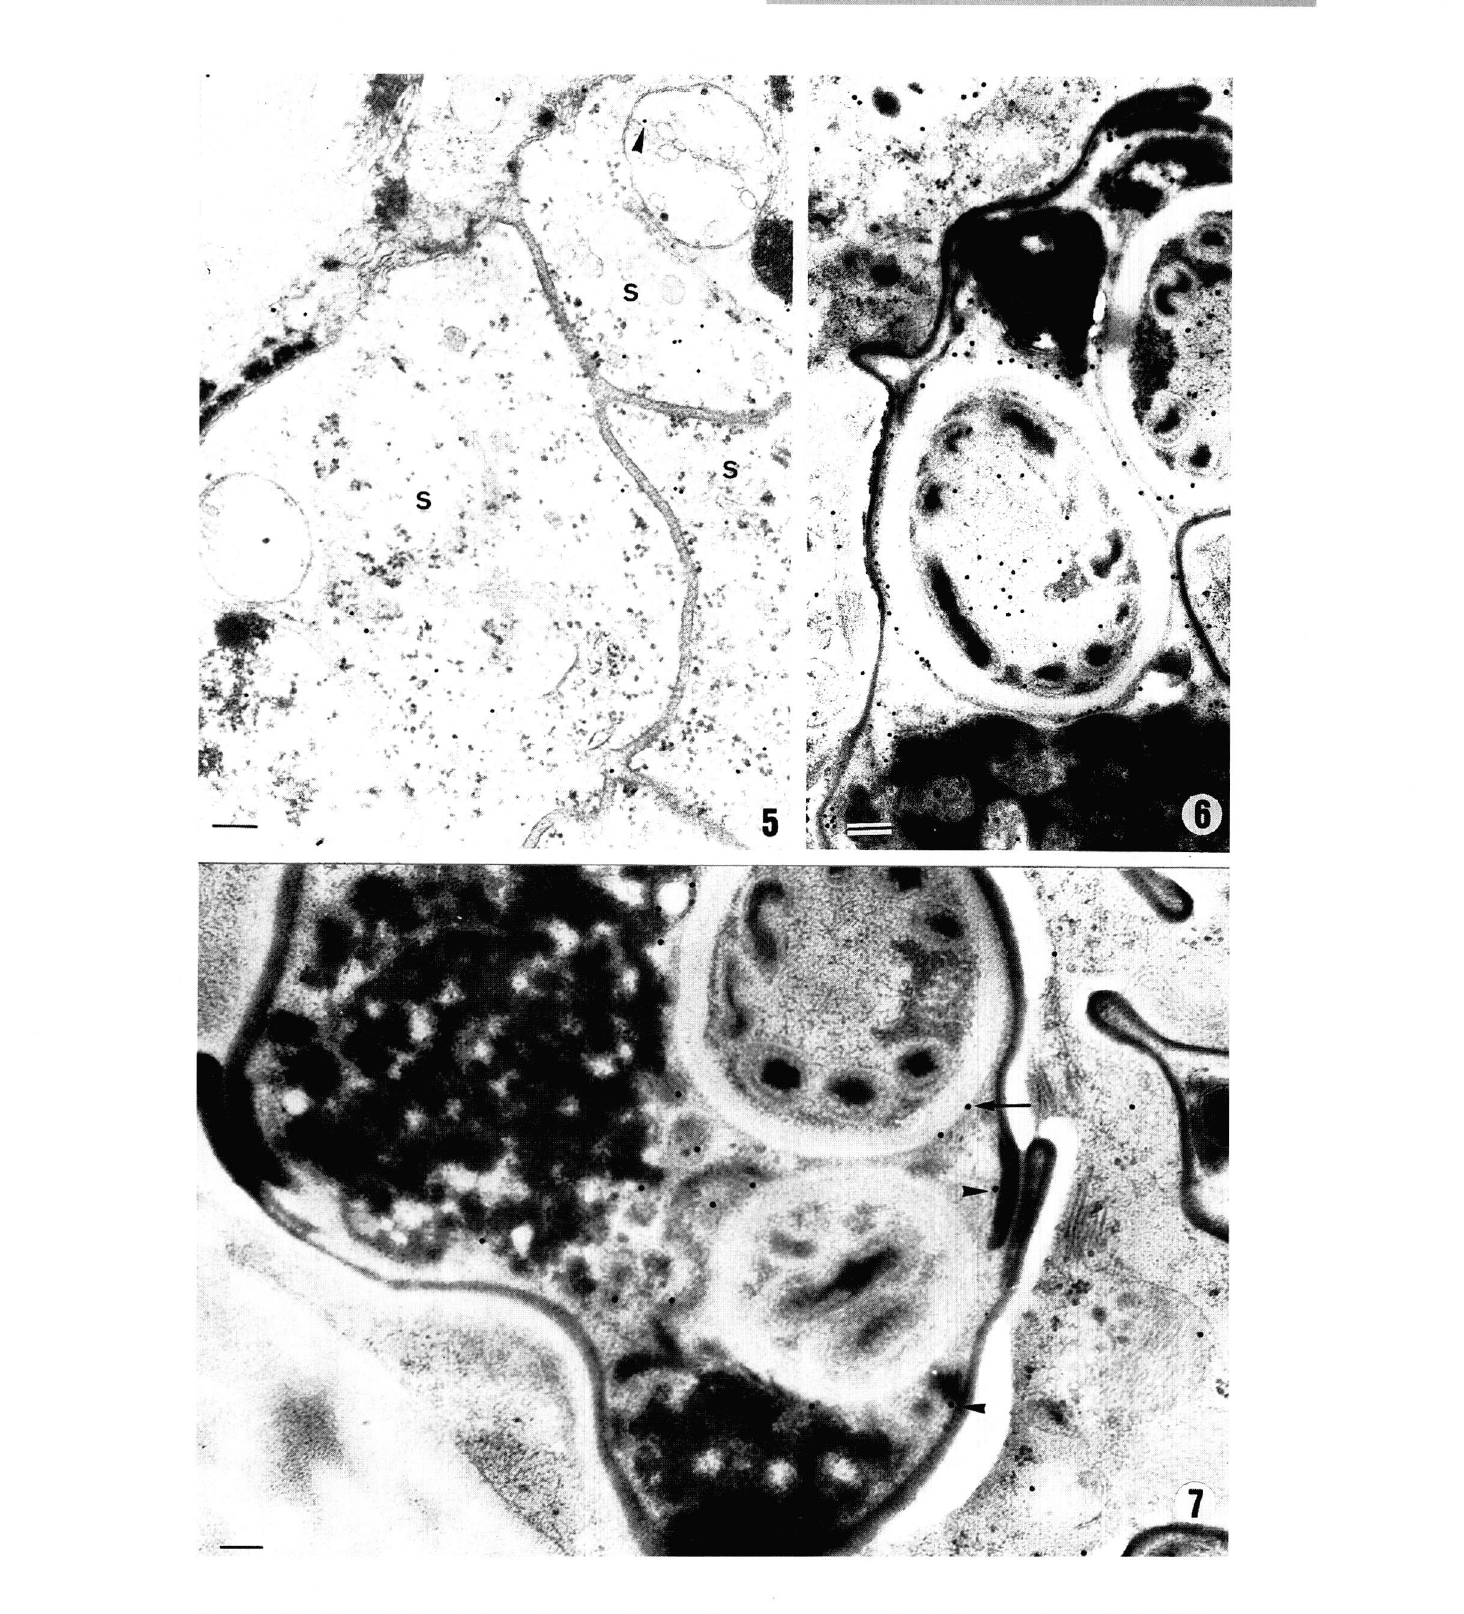
Figs. 5 to 7. — Transmission electron microscopy images of myxosporean parasites in tissue sections stained with lec tins. Fig. 5. - Polysporoplasma sparis in gilthead sea bream trunk kidney stained with SNA. Note the scattered labelling of the sporoplasms (S) and the very scarce staining in their mitochondria (arrowhead). Figs. 6, 7. Sphaerospora dicen trarchi in sea bass intestine. Fig. 6. - Staining with Con-A. Strong labelling in polar capsules and moderate staining in valves. Fig. 7. - Staining with WGA. Moderate staining in sporoplasms and weak labelling of polar capsule walls (arrow) and valves (arrowheads). Bars = 0.2 µm. Parasite, 2000, 7,